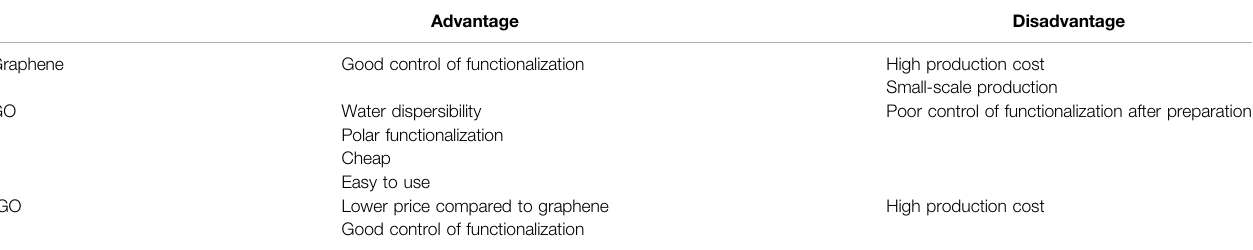
TABLE 5 | Advantages and disadvantage of graphene materials (Catania et al.,